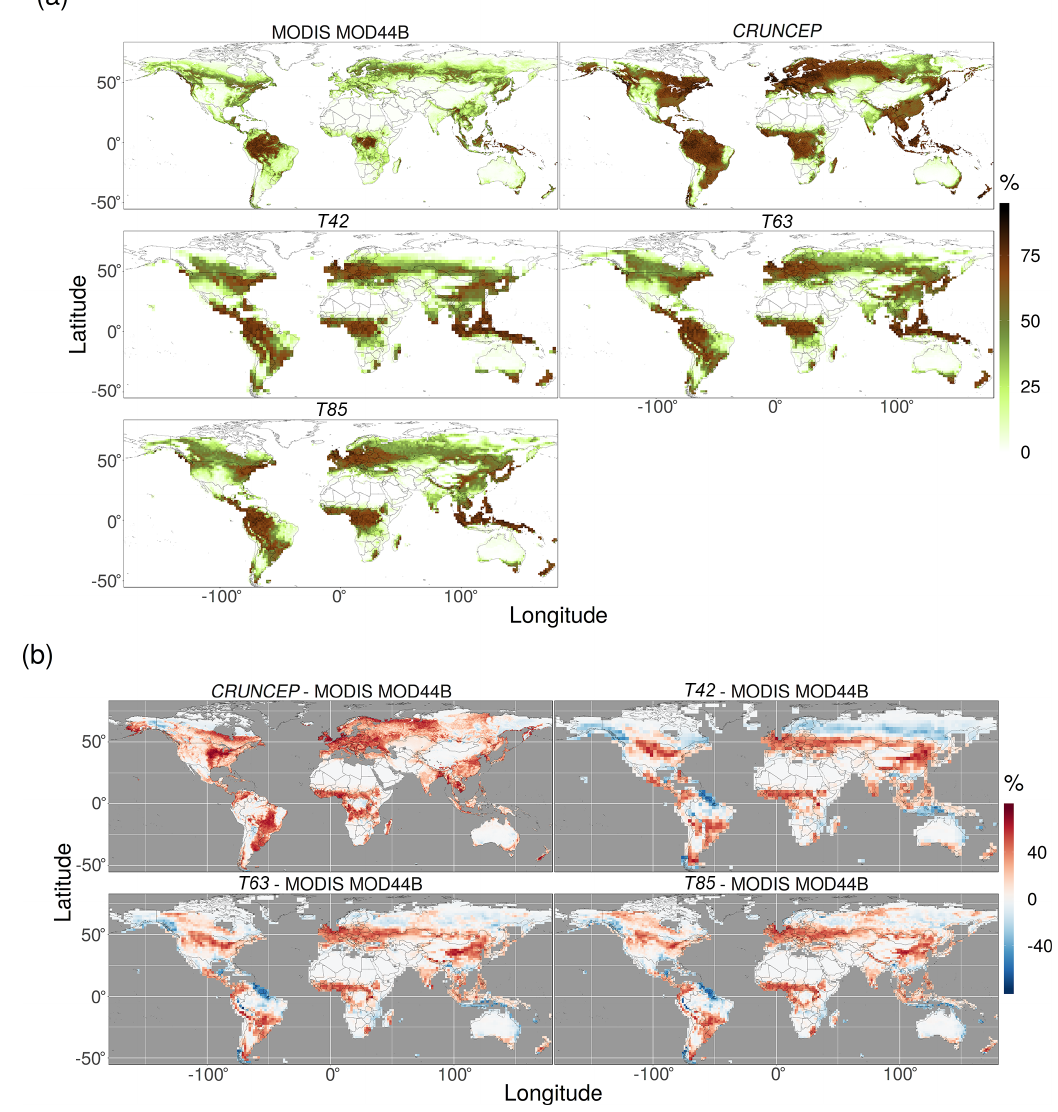
Figure 4. Comparison of tree cover from the T42 , T63 , and T85 (EMAC climate) and CRUNCEP (observed climate) simulations with observed tree cover from Dimiceli et al. (2015); (a) absolute values and (b) the difference between simulations minus observations.